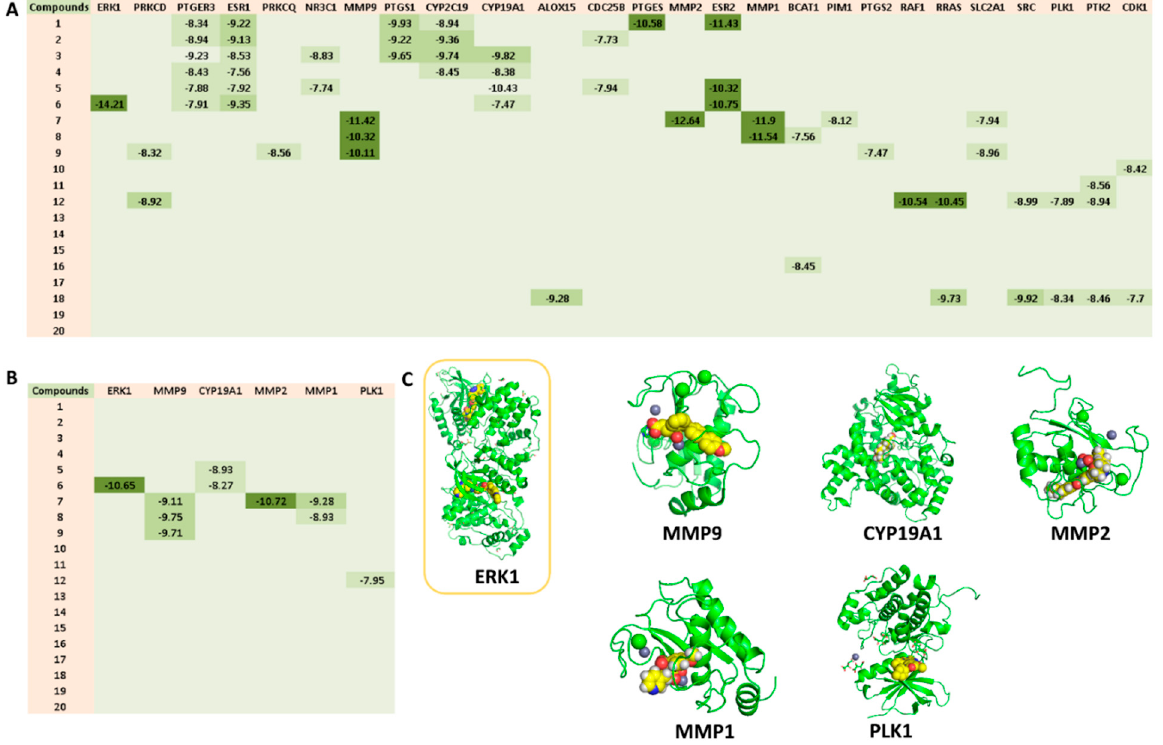
Figure 9. ( A ) Heat map showing docking scores in kcal/mol of compounds 1 – 20 with 26 BC ‐ related proteins. A cut ‐ off of − 7 kcal/mol was set to select the top ‐ scoring BC ‐ related protein targets for compounds 1 – 20 . ( B ) Heat map showing MDS ‐ derived Δ G values for a number of CE ‐ derived compounds inside the binding sites of 6 out of 26 protein targets ( C ) predicted to be potential BC targets. ERK1 (the protein structure inside a yellow rectangle) is one of the highly interacting proteins (i.e., hub proteins) in the BC PPI network.